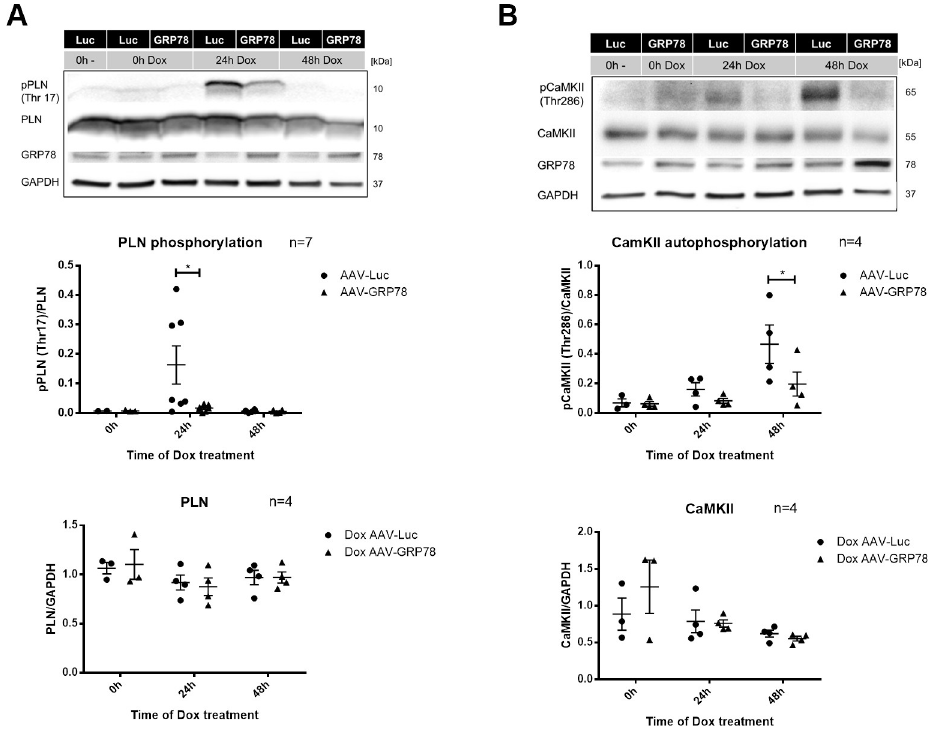
Fig 6. Ca 2+ /calmodulin-dependent protein kinase II (CaMKII) activity and phosphorylation after doxorubicin (Dox) treatment with glucose regulated protein 78 (GRP78) overexpression. Neonatal rat cardiomyocytes were transfected with adeno-associated virus 6 expressing GRP78 (AAV-GRP78) or Luciferase (AAV-Luc) two days prior to treatment with 1 μ M Dox. ( A ) Dox induced time dependent changes in (monomeric) phospholamban (PLN) levels (n = 4) and phosphorylation at Thr17 with AAV-GRP78 treatment (n = 7). ( B ) Time dependent changes in CaMKII levels (n = 4) and autophosphorylation at Thr286 after Dox treatment (n = 4). Glyceraldehyde 3-phosphate dehydrogenase (GAPDH) was used as housekeeping gene. Phosphorylated protein was normalized for total expression of respective protein � p < 0.05 for 2-way ANOVA with Bonferroni post hoc testing.